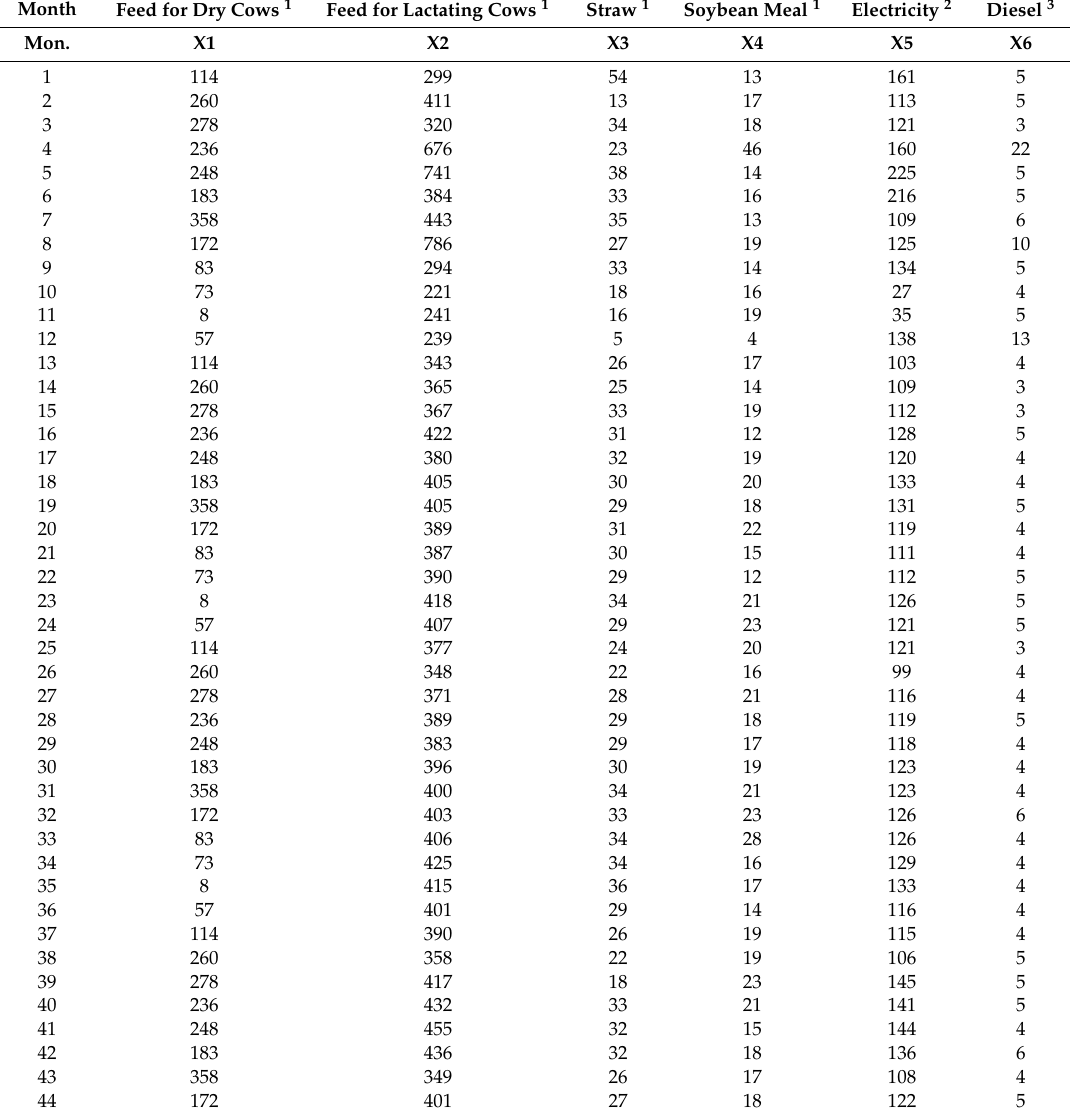
Table A1. The feed and utility input variables and their values of dairy